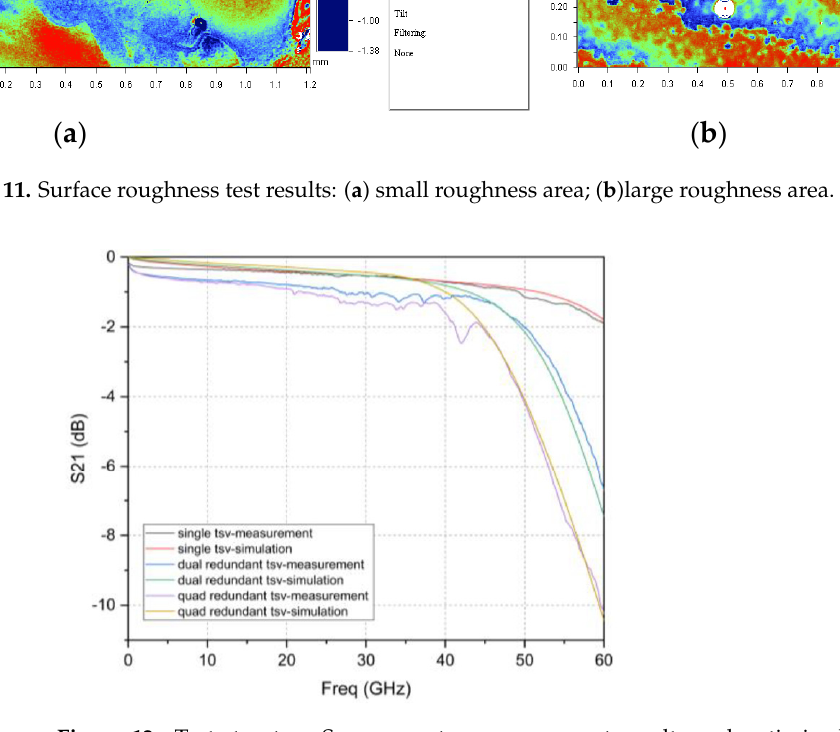
Figure 12. Test structure S 21 parameter measurement results and optimized simulation results of HFSS. 5. S-Parameter Extraction To obtain the precise value of insertion loss contributed by RF redundant TSVs, de- embedding was conducted. According to the relevant theory of microwave network pa- rameters, conversion into ABCD parameters with cascade characteristics for RF redun- dant TSV sample structures was carried out via parameter transformation and matrix op- eration [33]. The 1000 μ m CPW test structure is viewed as four 250 μ m CPW connections. A single RF TSV interconnect and redundant RF TSV interconnect test structure is viewed as three CPW and two TSV interconnect structures, as shown in Figure 13. To simplify the description, J1, J2, J3, and J4 are used to represent the CPW, single TSV interconnect, dual